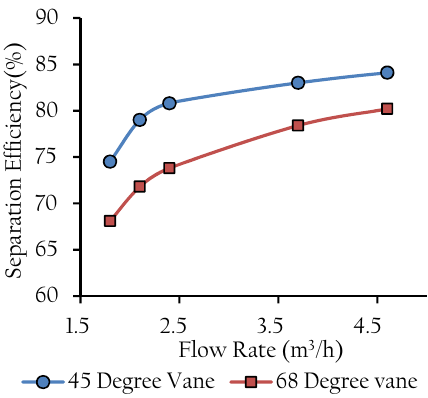
Fig. 8 Separation efficiency vs flow rate at various vane angles